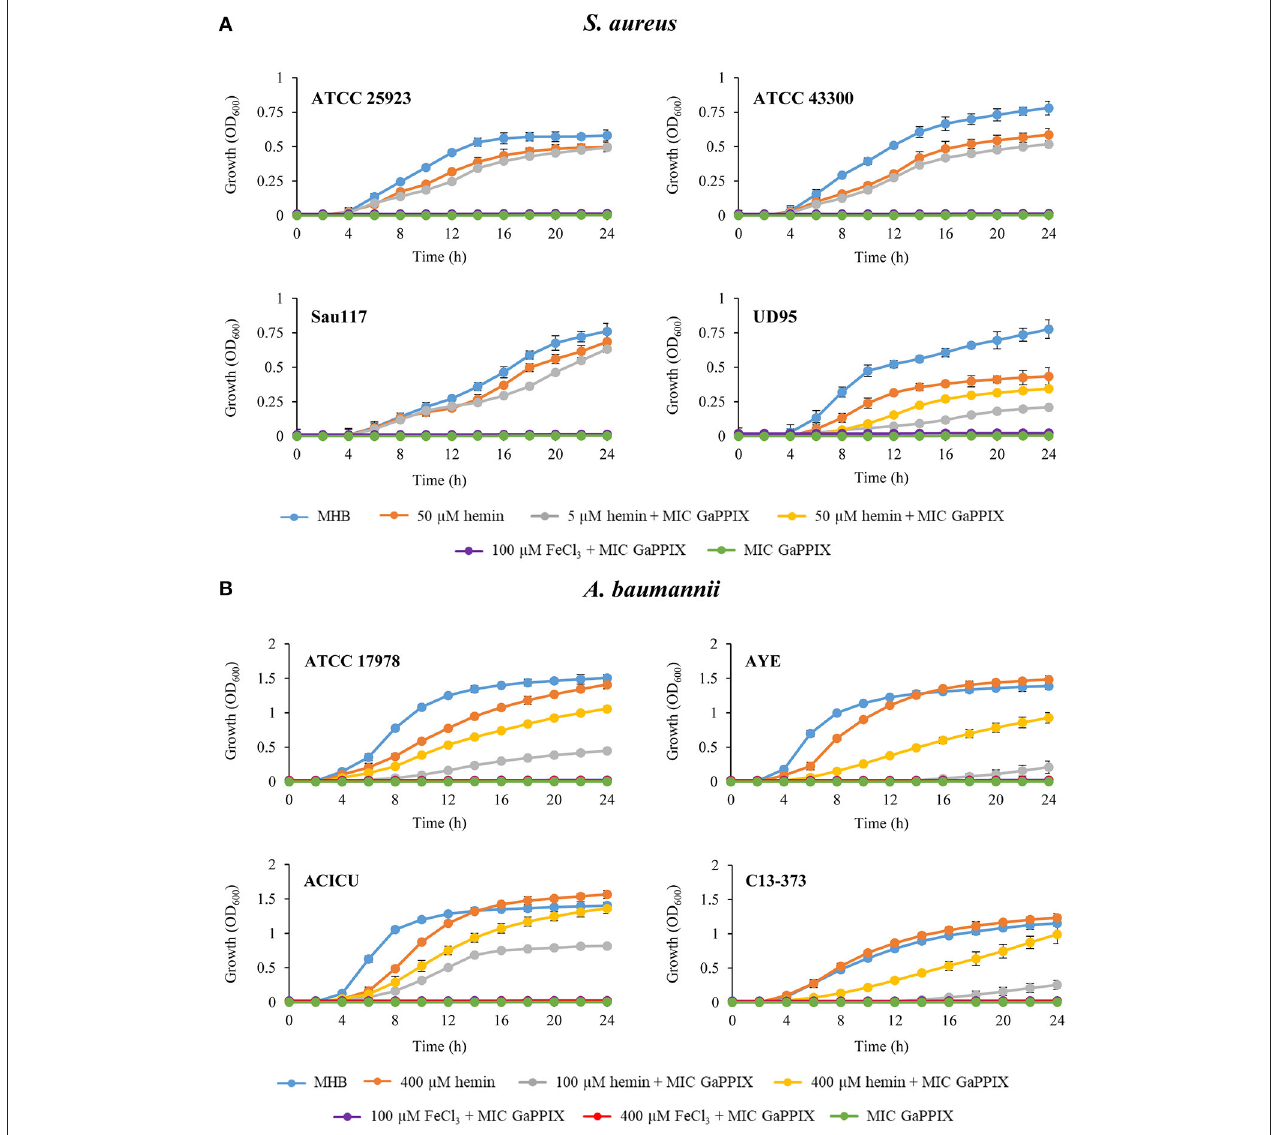
FIGURE 2 | Effect of iron and hemin on the inhibitory activity of GaPPIX. Strains were grown in MHB supplemented or not with GaPPIX at the MIC. Hemin and FeCl 3 were supplied at different concentrations, either alone or in combination with GaPPIX, as indicated. (A) S. aureus ATCC 25923, ATCC 43300, Sau117, UD95, and (B) A. baumannii strains ATCC17978, AYE, ACICU and C13–373. OD 600 was monitored periodically for up to 24h. Data are the mean ± standard deviation of triplicate experiments.